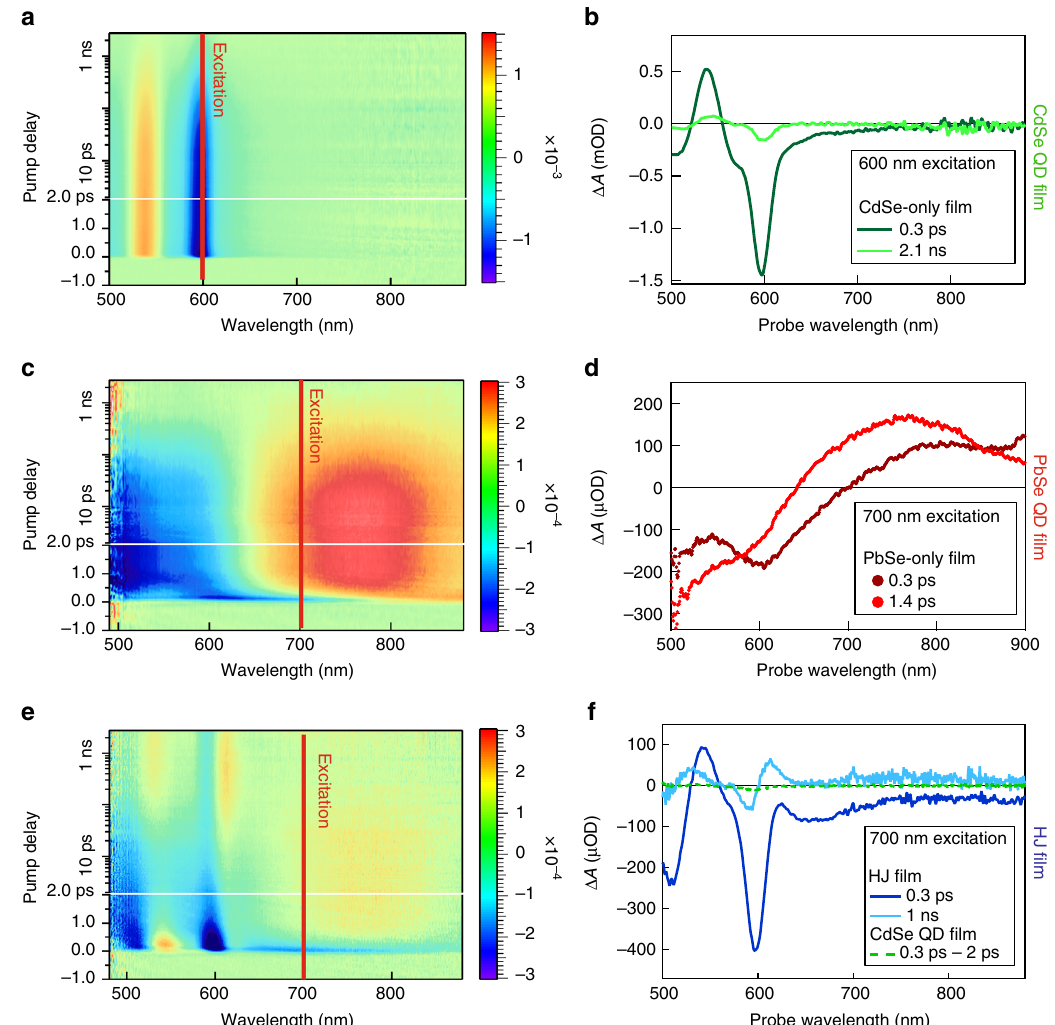
Fig. 2 Transient absorption on QD fi lms. a Color map showing the differential absorbance of a fi lm composed of 4.5 nm CdSe QDs, excited at 600 nm with a fl uence of 1.27 × 10 13 photons/cm 2 per pulse (0.07 excitons per CdSe QD). b Spectral cuts of ( a ), showing the TA response for two delay times after photoexcitation. c Color map showing the differential absorbance of a fi lm composed of 2.3 nm PbSe QDs, excited at 700 nm with a fl uence of 9.84 × 10 13 photons/cm 2 per pulse (0.39 excitons per PbSe QD). d Spectral cuts of ( c ). e Color map showing the differential absorbance of a QDHJ fi lm, composed